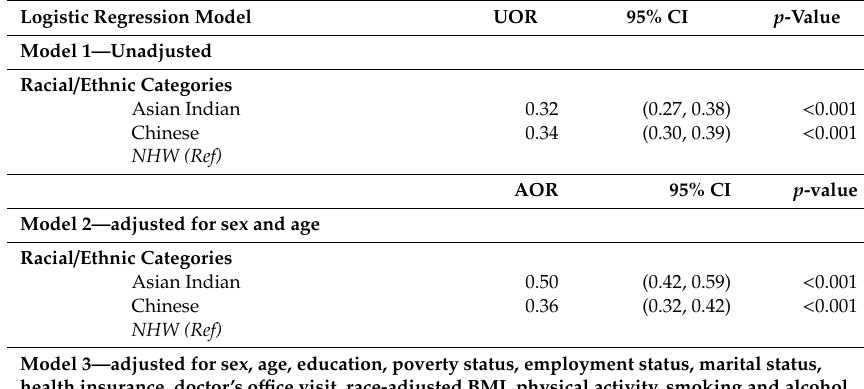
Table 3. Unadjusted Odds Ratios (UOR) and Adjusted Odds Ratios (AOR) and 95% Confidence Intervals (CI) of racial / ethnic categories from logistic regression on multimorbidity among Asian Indian, Chinese, and Non-Hispanic White (NHW) adults (age ≥ 18 years). National Health Interview Survey,